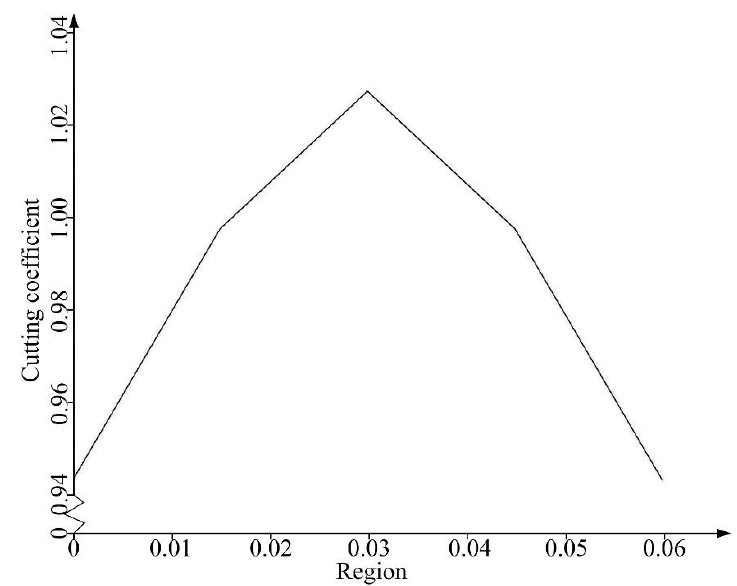
Figure 18. The theoretical cutting coefficient curve of complex surface.